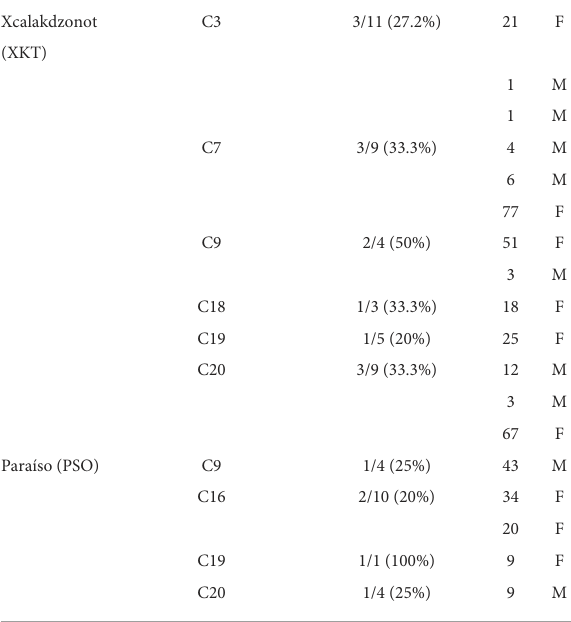
FIGURE3 Spatial distribution of ZIKV-positive pools of vertebrates and flavivirus positive mosquitoes from Xkalakdzonot (XKT), Yucatan, Mexico. Positive households include the icons of vertebrates or mosquito pools positive in each dwelling. Mosquito species identity for each household is shown in Supplementary Table 2. Map coordinates were removed to protect the privacy of the patients involved.